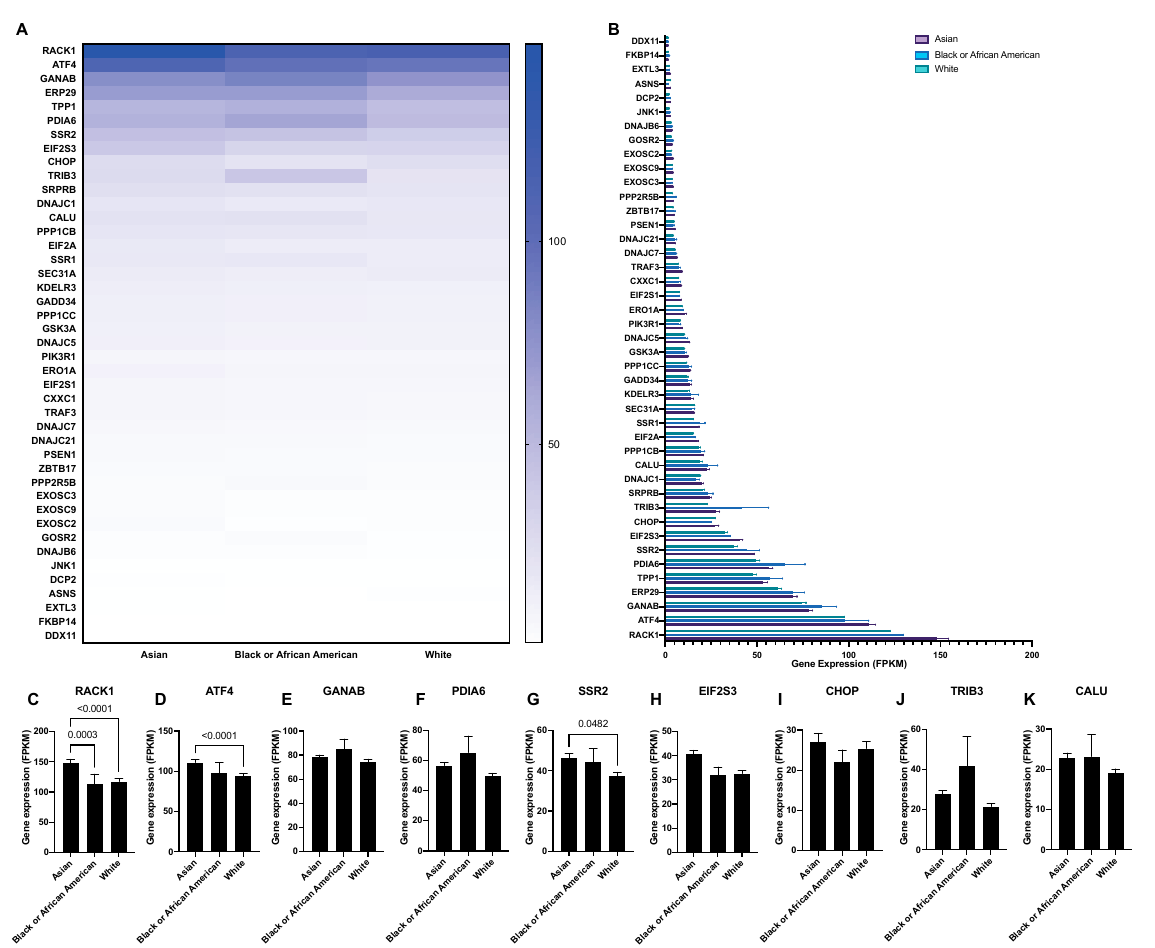
Figure 8. The mRNA expression of unfavorable UPR-associated markers per ethnic group shown in a heatmap ( A ) and a bar chart ( B ). The selected markers shown as individual bar charts ( C – K ).